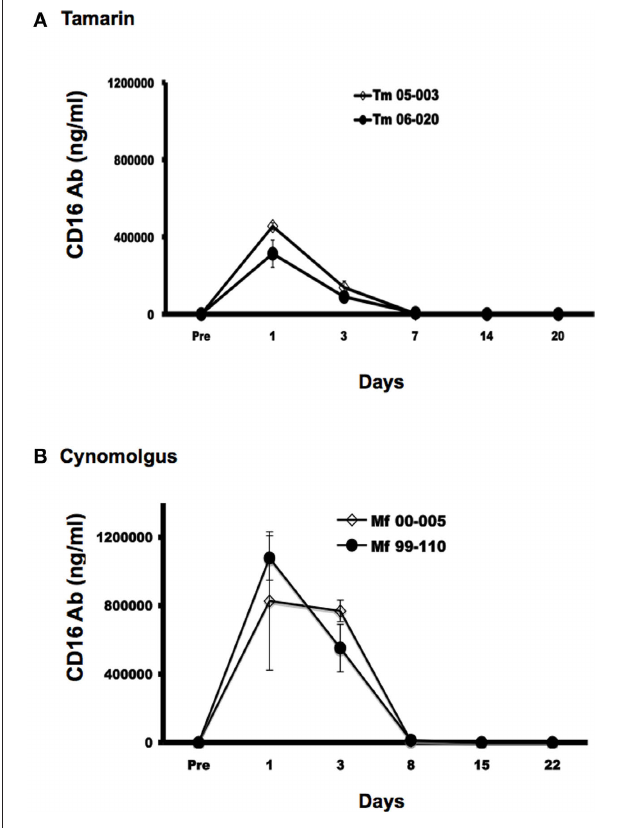
Figure 6 | Kinetics of concentration of CD16 (3g8) mAb in vivo . The concentration of CD16 (3G8) mAb in plasma was measured by ELISA as described in Section “Materials and Methods”. Results shown are representative of three independent experiments. (A) Tamarins: Tm 05-003 and Tm 06-020. (B) Cynomolgus monkeys: Mf 00-005 and Mf